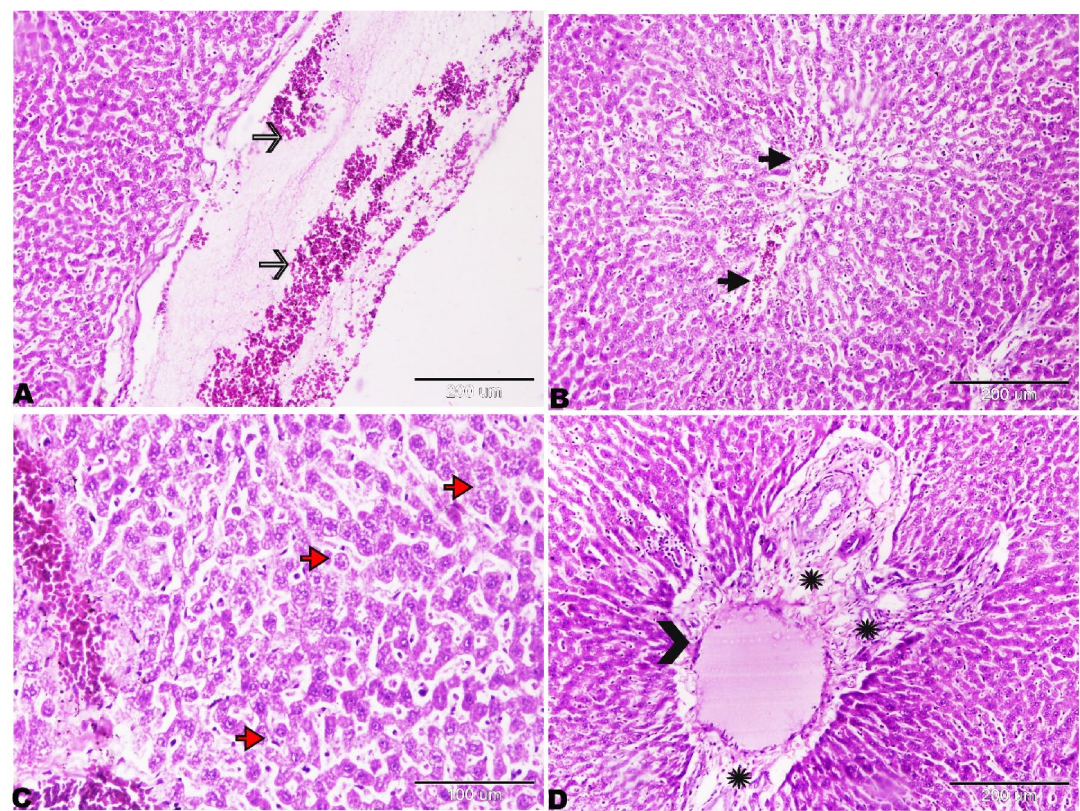
Figure 9. Photomicrograph of rat liver of Group II (treated with basal diet 70% + control cheese 30%). ( A ) Glisson capsule surrounding the liver was thickened and exhibits severe hemorrhage and edema (arrows). ( B ) Central vein was dilated and engorged with blood (arrows). ( C ) Dissociation of hepatic cords and vacuolation of hepatocytes (red arrows). ( D ) The portal areas showing dilated and congested portal veins (black arrowheads), periportal edema mixed with fine threads of fibrosis (stars). H&E stain, the bar size was indicated under